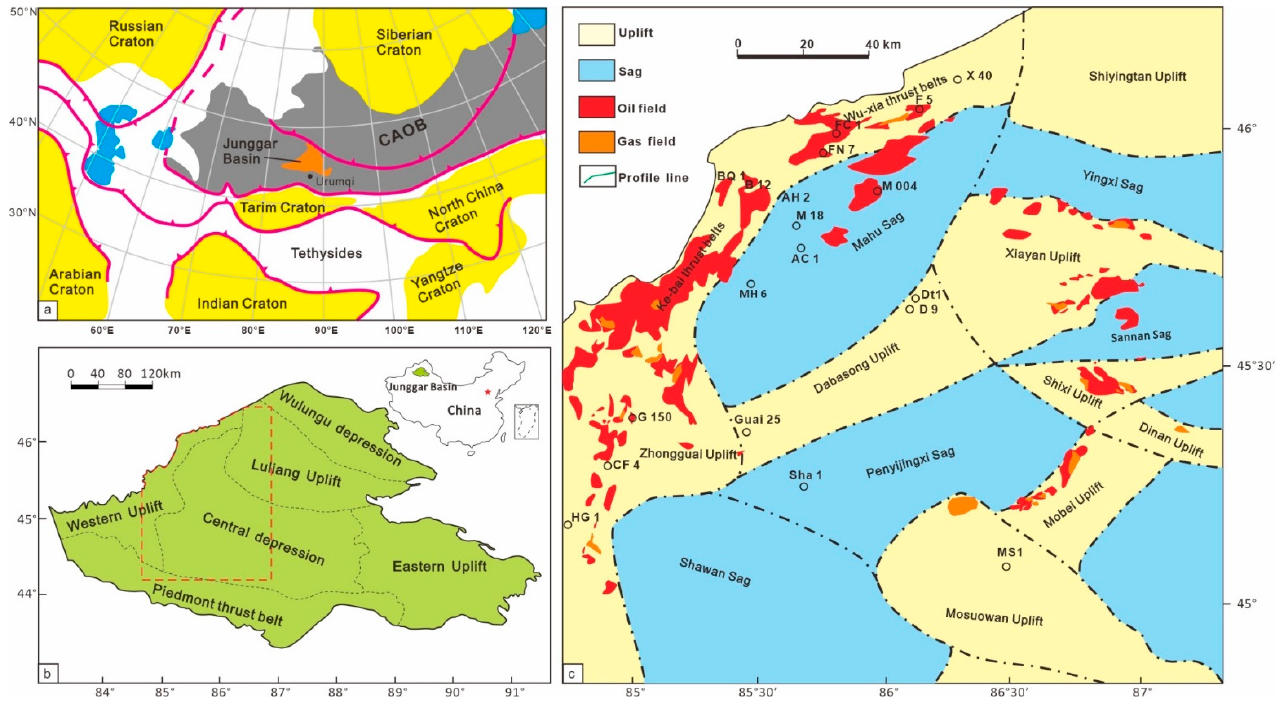
Figure 1. Location of Junggar Basin and study area in the Basin (Modified after reference [10]). ( a ) geotectonic setting of the Junggar Basin; ( b ) tectonic unit of the Junggar Basin; ( c ) study area tectonic unit and petroleum, exploration well distribution. Reprinted with permission from Ref. [10]. 2020, Elsevier.